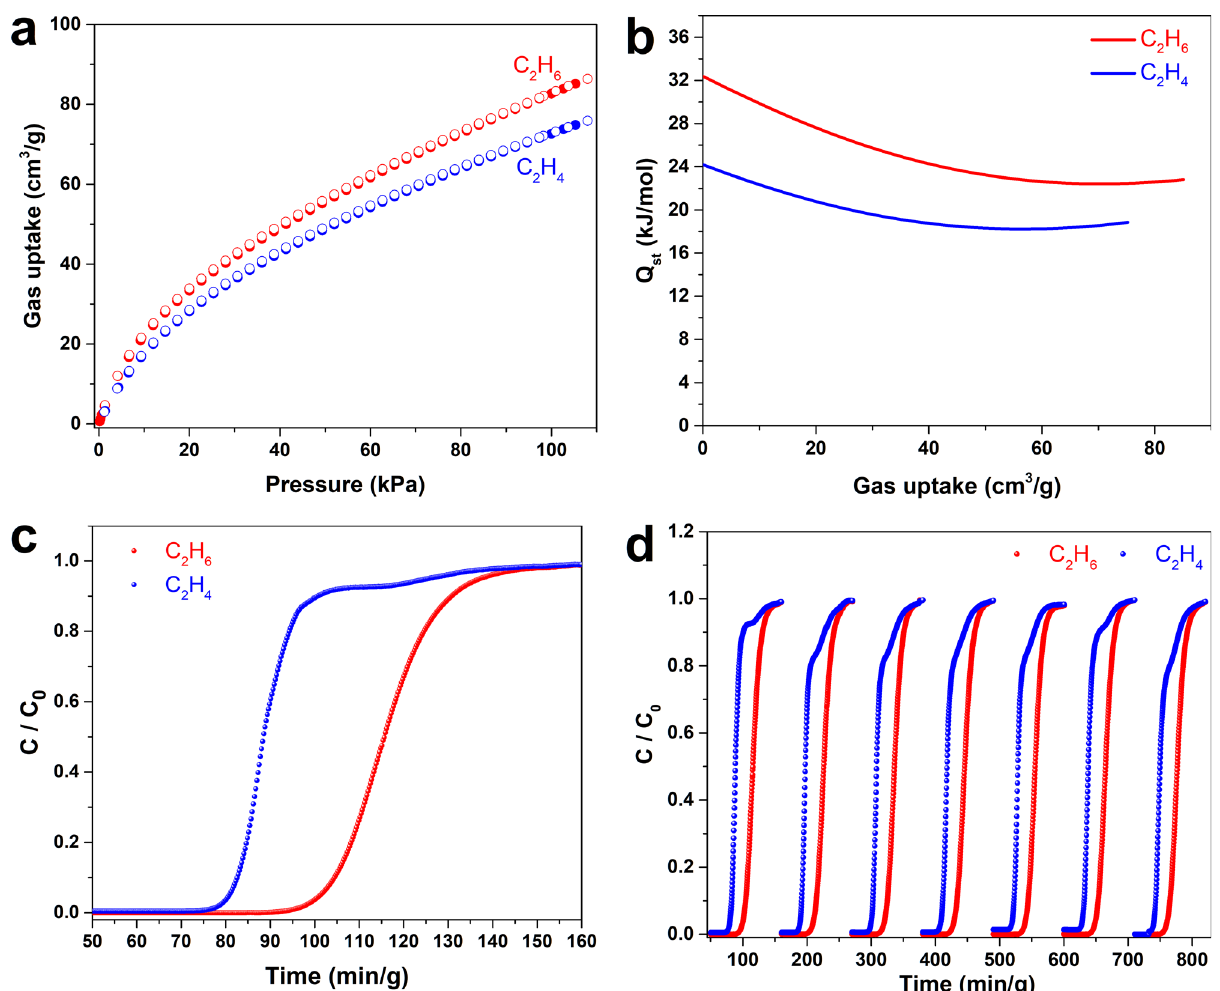
Fig. 3 C 2 H 6 /C 2 H 4 separation performances. a Experimental C 2 H 6 and C 2 H 4 adsorption isotherms of CPOC-301 at 293 K. b Isosteric heat of adsorption plots for the adsorption of C